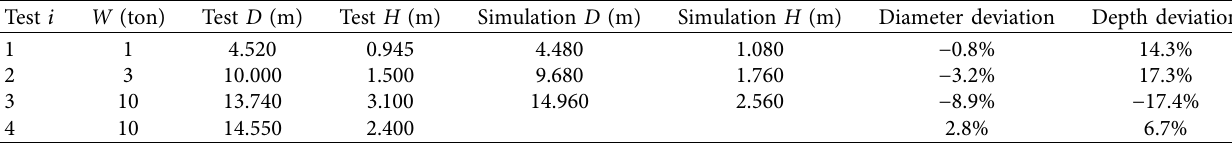
Table 5: Simulation results for the four test craters.